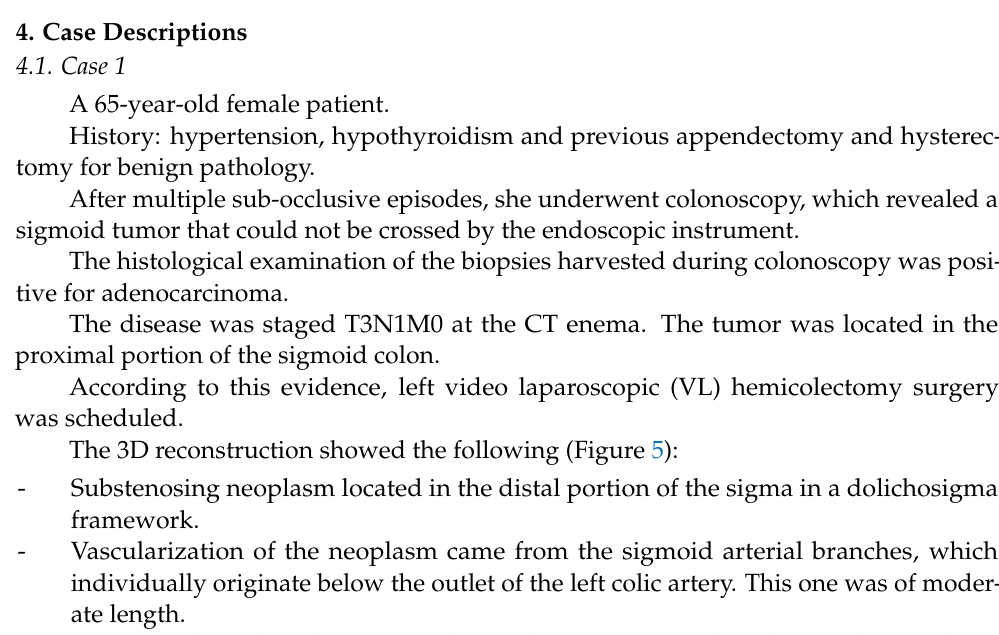
Figure 4. Frequency distribution of tumor localization based on 3D reconstruction, CT/MRI scans and intraoperative findings. (LC: left colon, RC: right colon, R: rectum, T: transverse colon, N.A.: not